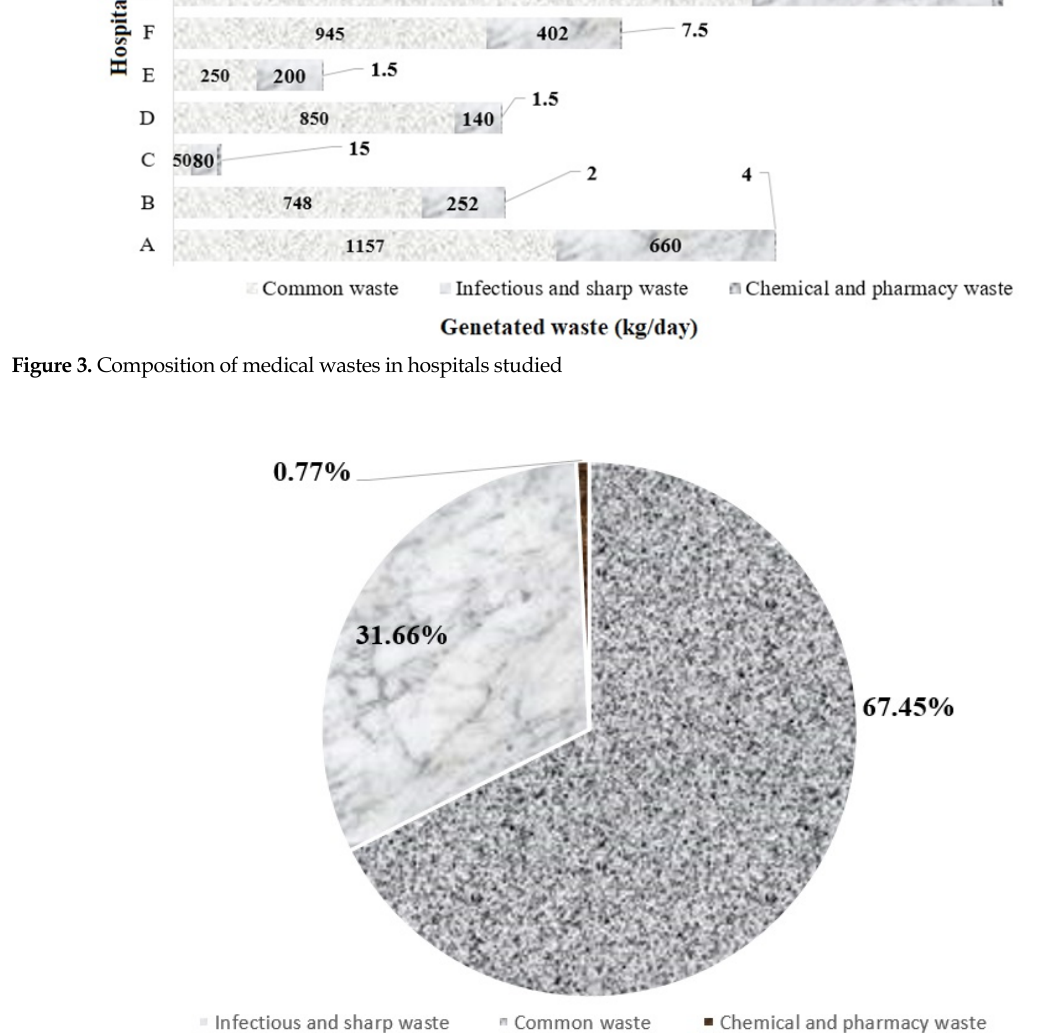
Figure 4 . Composition of medical waste in the hospitals